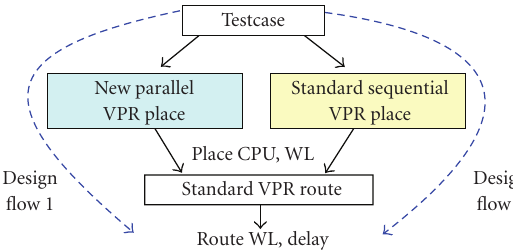
Figure 6: The flow diagram of the experimental setup with two design flows: first design flow uses the proposed parallel VPR placement algorithm and the second design flow uses the standard sequential VPR placement